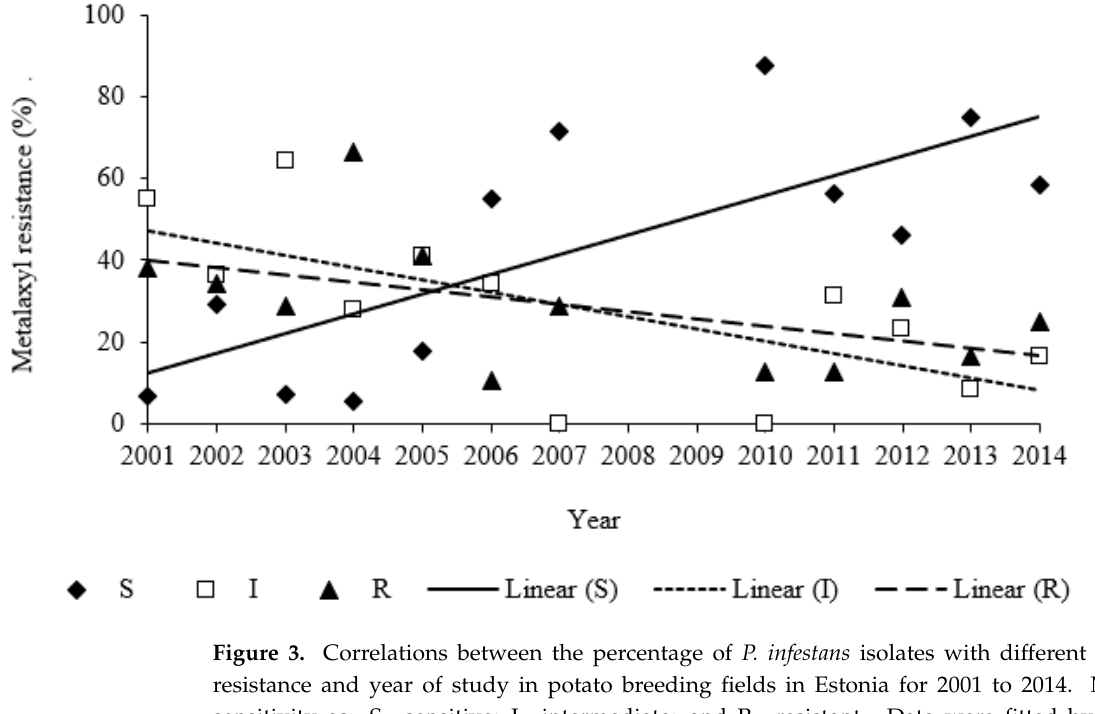
Figure 2. Variation in the percentage of P. infestans isolates with different metalaxyl-sensitivity from potato breeding fields in Estonia during 2001–2007 and 2010–2014. Metalaxyl-sensitivity as: S—sensitive; I—intermediate; and R—resistant. n is the total number of isolates assessed for met- alaxyl-sensitivity in each year.